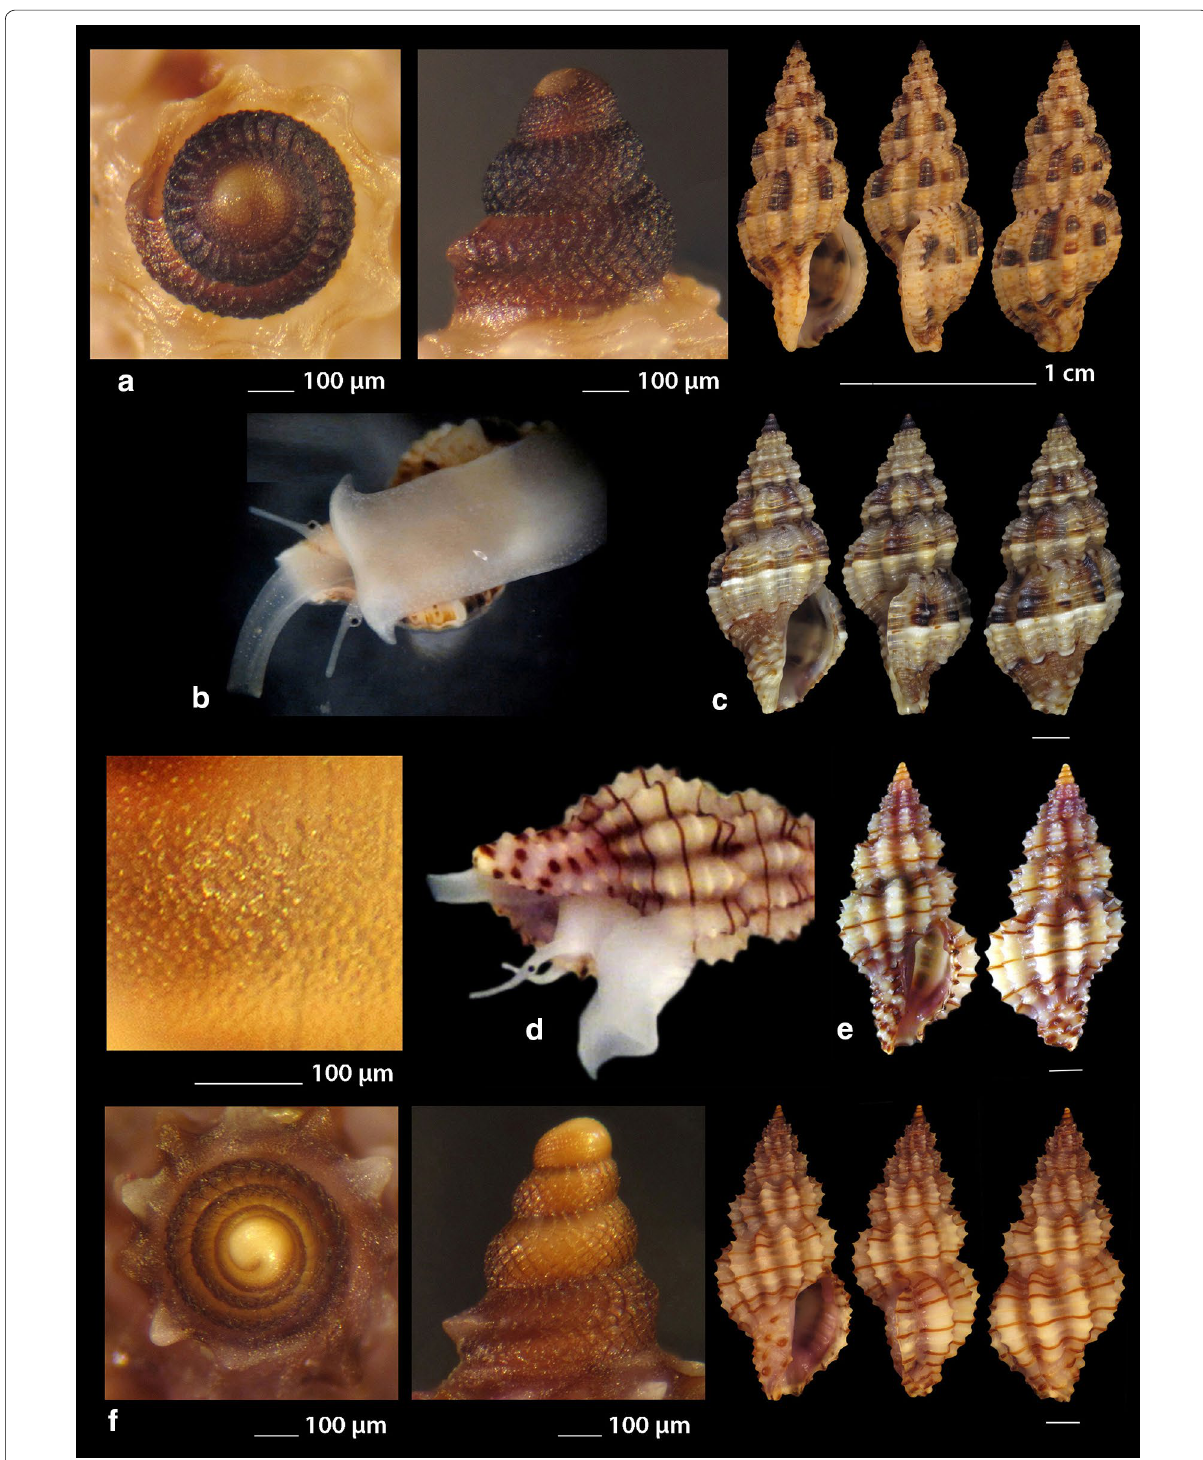
Fig. 14 a – c Raphitoma leufroyi , b live specimen, d – f Raphitoma linearis , d live specimen. Bar